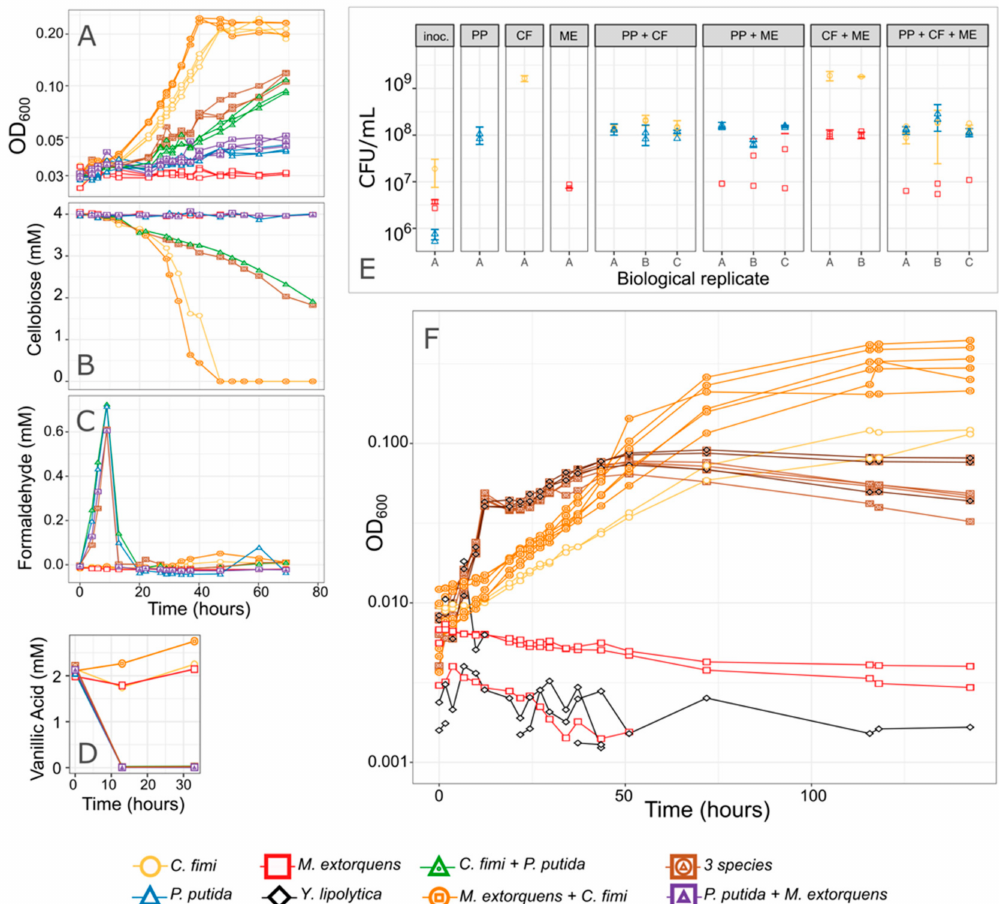
Figure 7. P. putida inhibits C. fimi growth. ( A – E ) Results from an experiment in which each organism was grown in pure culture and in combinations, in minimal medium containing cellobiose and a low concentration of vanillic acid. The combination of species in each culture tube is indicated by the color and shape of the points. ( A ) Growth of the entire community as measured by optical density. Cultures without P. putida grew most rapidly and reached the highest final OD. No increase in OD was attributed to P. putida because 2 mM vanillic acid supports very little growth. ( B ) Cellobiose concentrations over time. C. fimi is the only organism capable of consuming cellobiose, and consumption was most rapid in cultures lacking P. putida . ( C ) Formaldehyde concentrations and ( D ) Vanillic acid concentrations over time. Formaldehyde peaked and disappeared, and vanillic acid was consumed, within 12 h, indicating activity by P. putida despite fact that the change in OD was not measurable. ( E ) Viable cells from each species, as measured by colony counts, at the beginning of the experiment (“inoc.” = inoculum), and at the end (78 h; each panel is titled with the species present in that culture tube). While no growth substrate was explicitly included to support M. extorquens , it increased slightly in abundance by the end of the experiment and the greatest increase was in the presence of C. fimi and absence of P. putida . Replicate culture tubes are shown along the x -axis; points indicate replicate measurements from each tube. ( F ) Results from a similar experiment, testing only a subset of the species combinations in Model Lignocellulose medium. Only optical density is shown